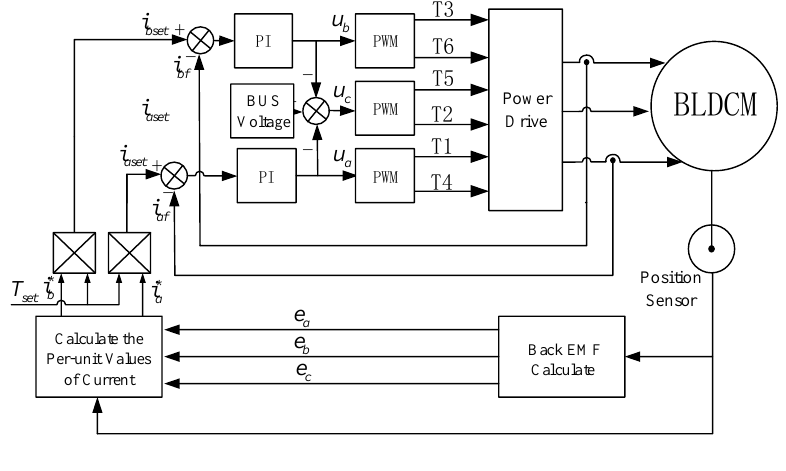
Figure 6. Control diagram of COC.